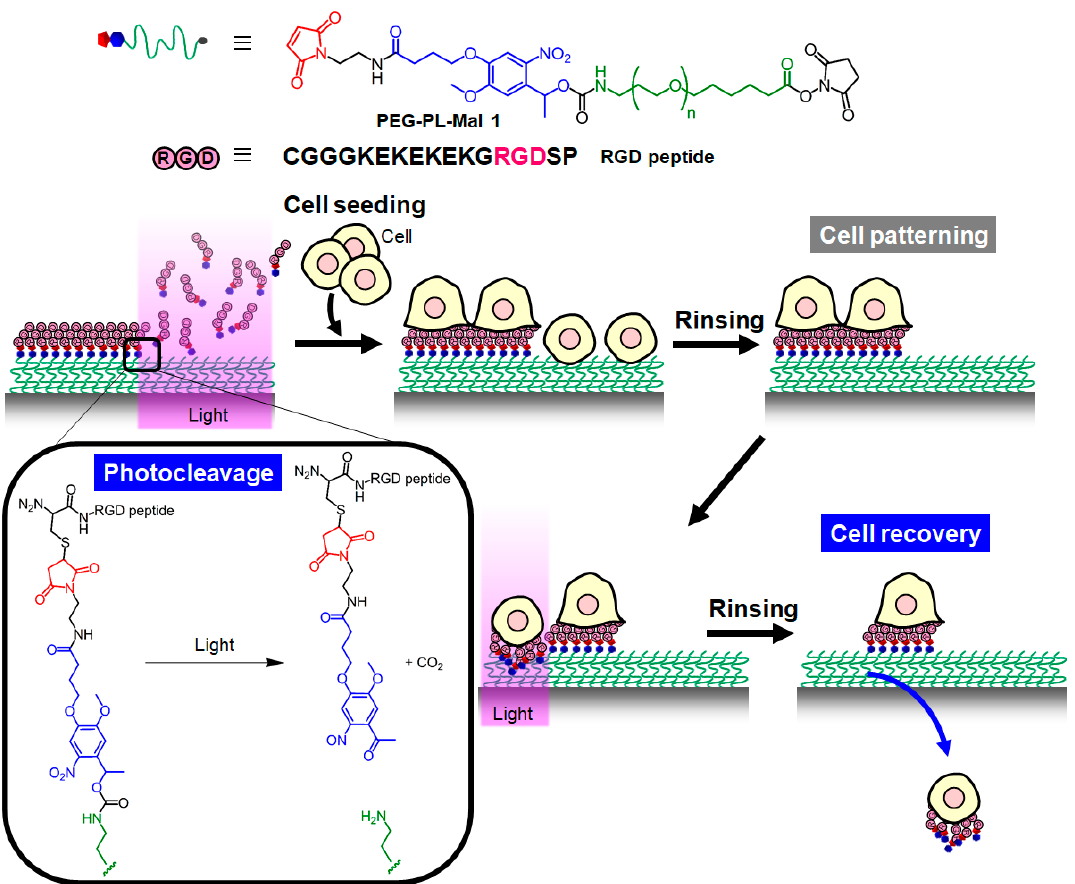
Figure 1. Schematic illustrations of light-guided cell patterning and recovery on a photocleavable RGD-PEG surface. The chemical structure of PEG-PL-Mal 1 and the amino acid sequence of the RGD peptide are shown ( top ) with the reaction scheme of the photocleavage on the surface ( left bottom ).